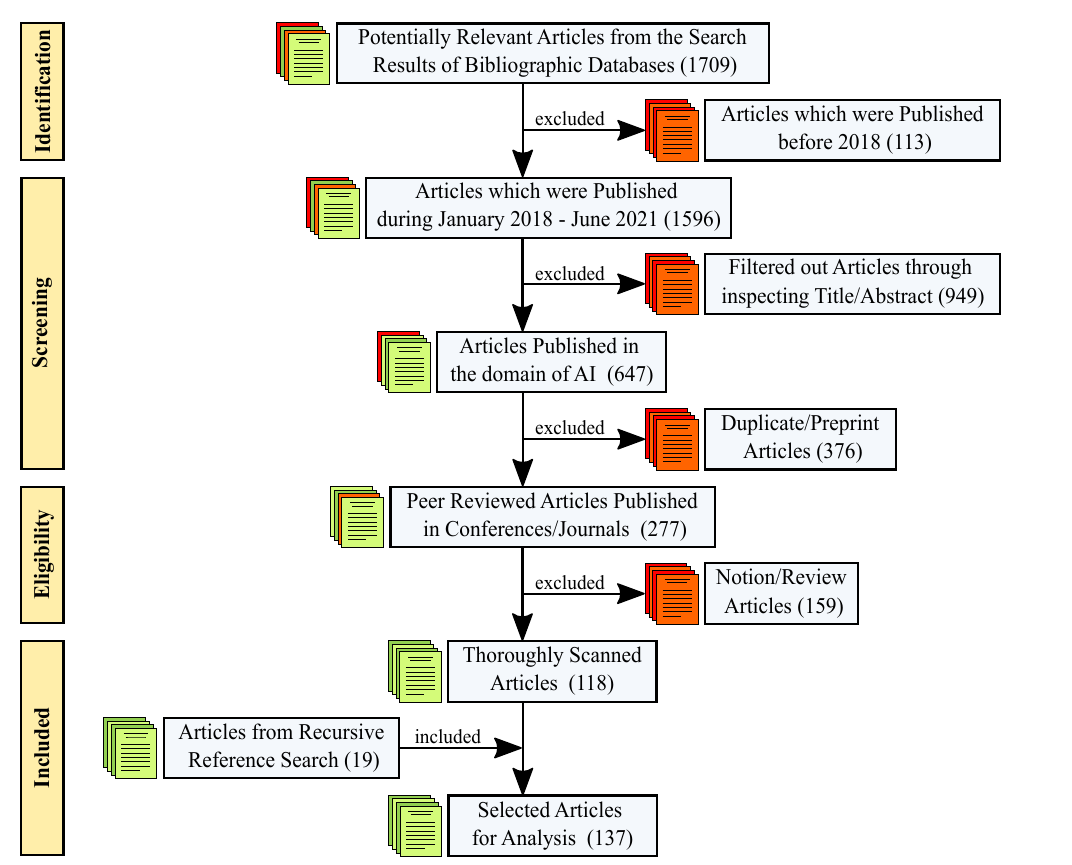
Figure 5. Flow diagram of the research article selection process adapted from the PRISMA flow chart by Moher et al. [40]. The number of articles obtained/included/excluded at different stages is presented in